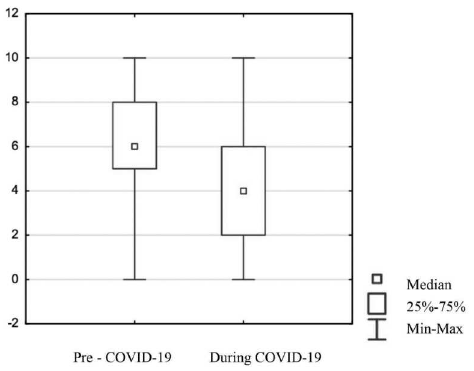
Figure 2. Comparison of scores concerning the quality of health services before and during the COVID-19 pandemic for all respondents